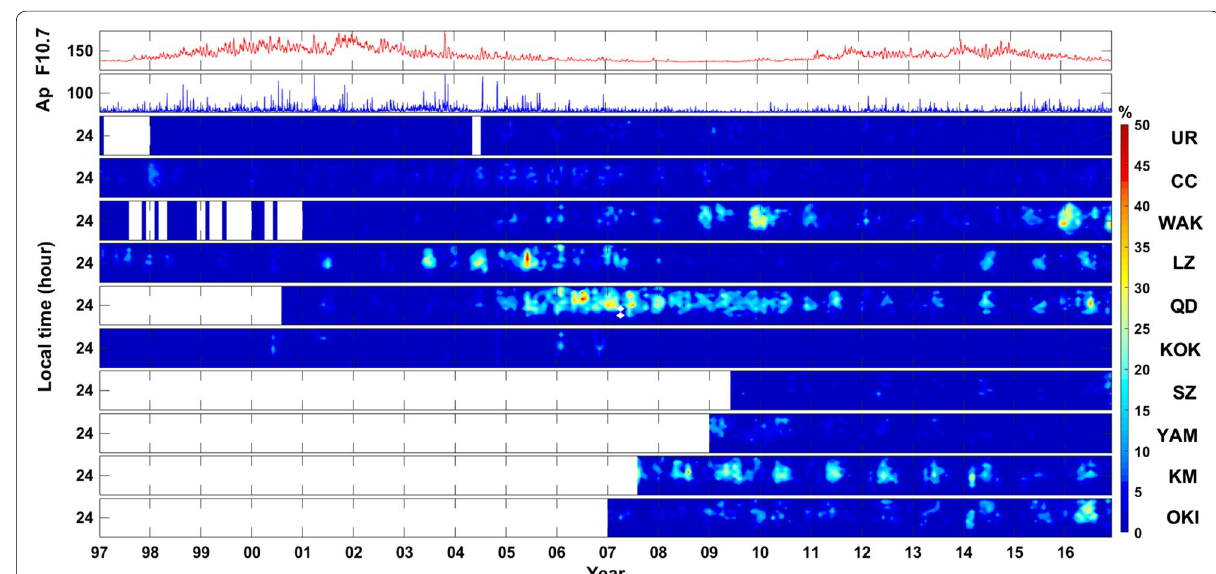
Fig. 6 Variations in daily F10.7, Ap index and monthly mean of RSF occurrence percentages at the 10 stations; the x -axis is the year and the y -axis is the local time